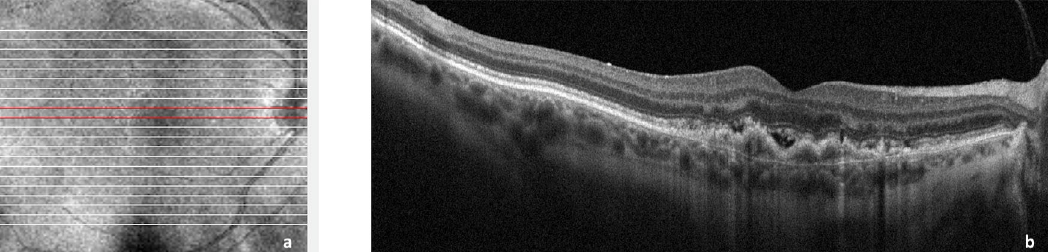
Figure 1. Spectral domain optical coherence tomography (SDOCT) of the macular area showing choroidal neovascularization (CNV) secondary to age-related macular degeneration. ( a ): Image of the macula showing overlying raster scan; ( b ): cross-sectional SDOCT scan showing retinal pigment epithelium (RPE) elevation due to CNV underlying the RPE and adjacent subretinal fluid.